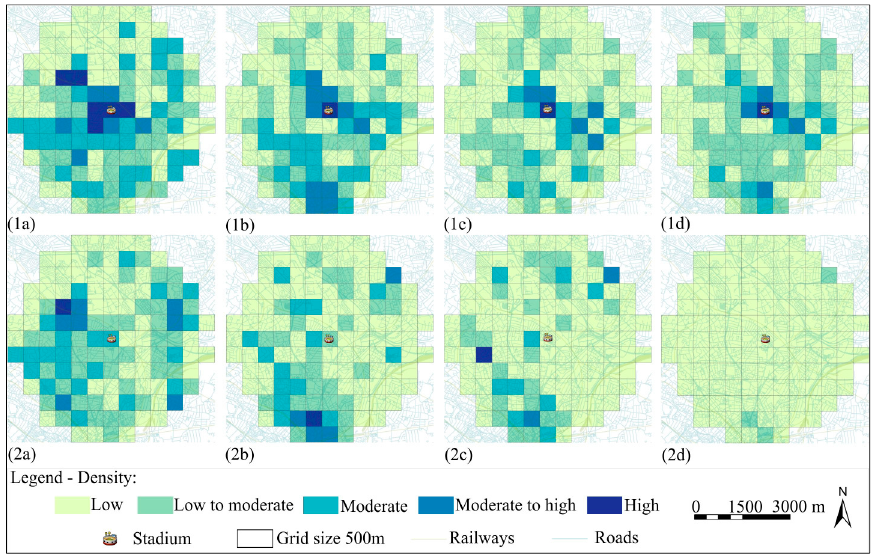
Figure 8. Density maps ( a ) amalgamated crimes, ( b ) geotagged tweets, ( c ) violent tweets, and ( d ) football-related tweets; ( 1 ) match days, ( 2 ) comparison days (using the Natural Jenks classification method).